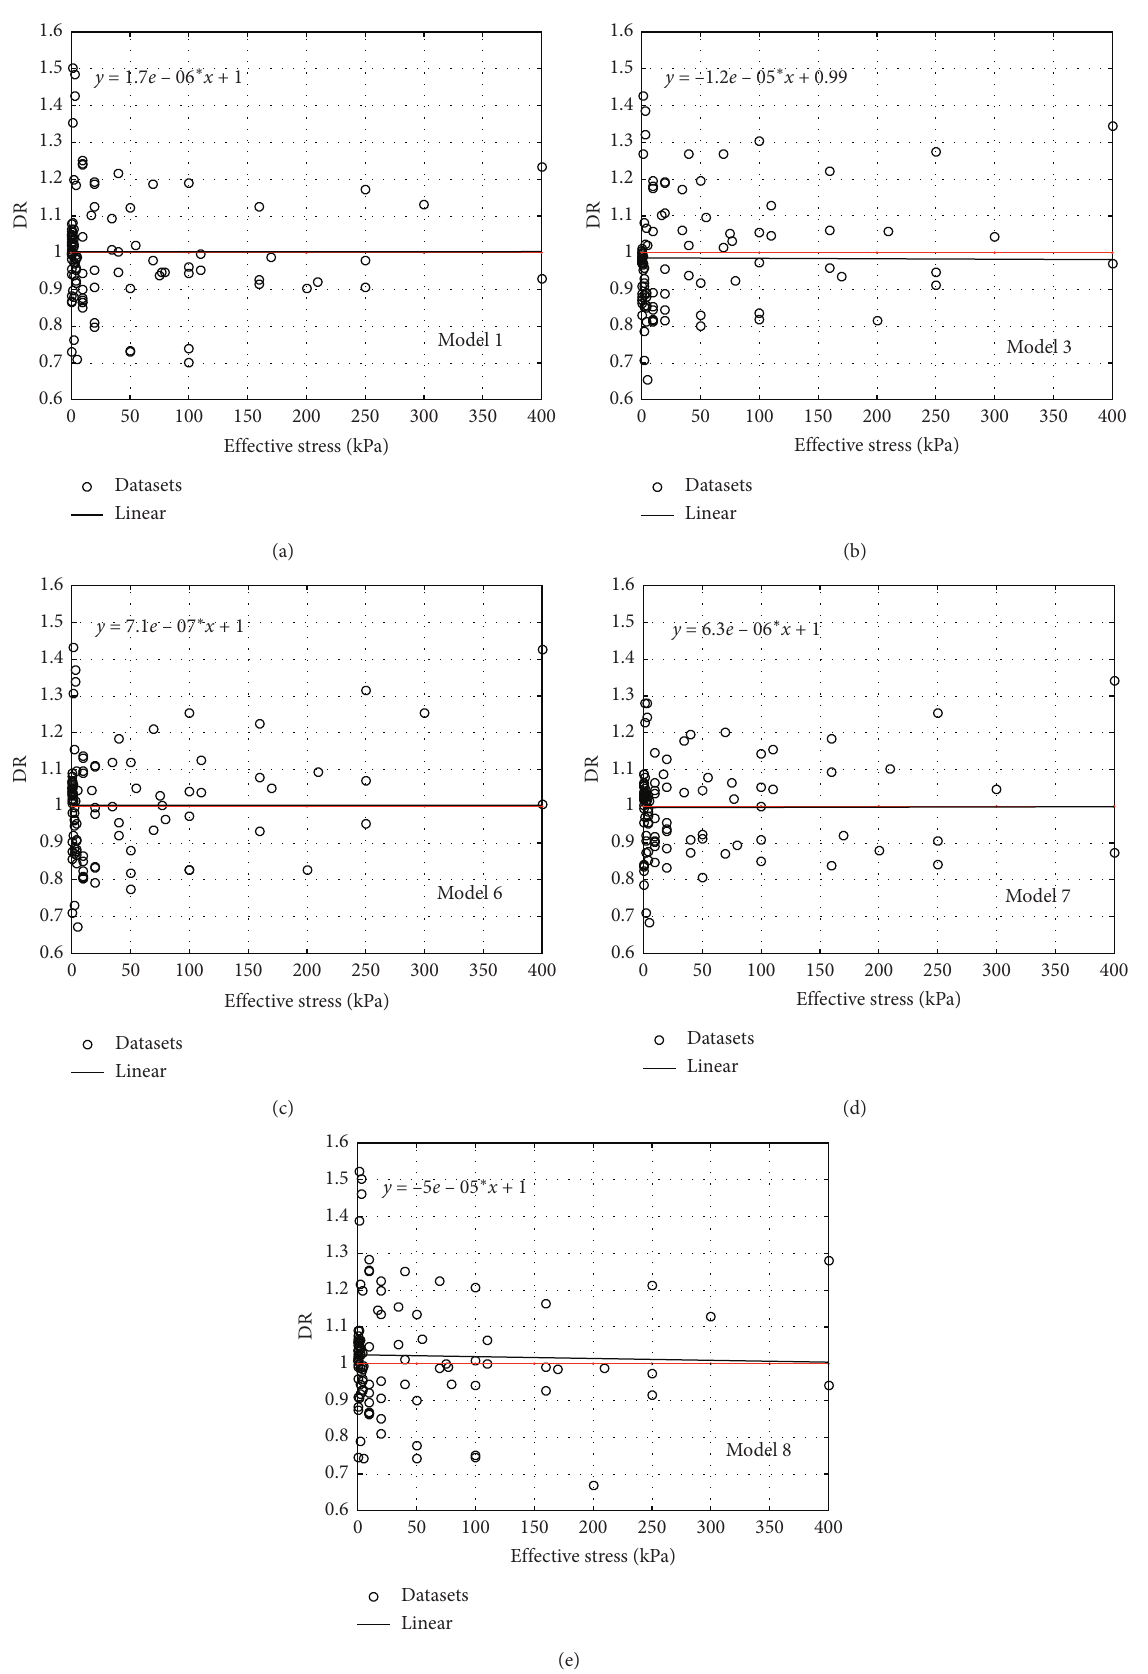
Figure 3: Variation of DR against effective stress for (a) Model 1, (b) Model 3, (c) Model 6, (d) Model 7, and (e) Model